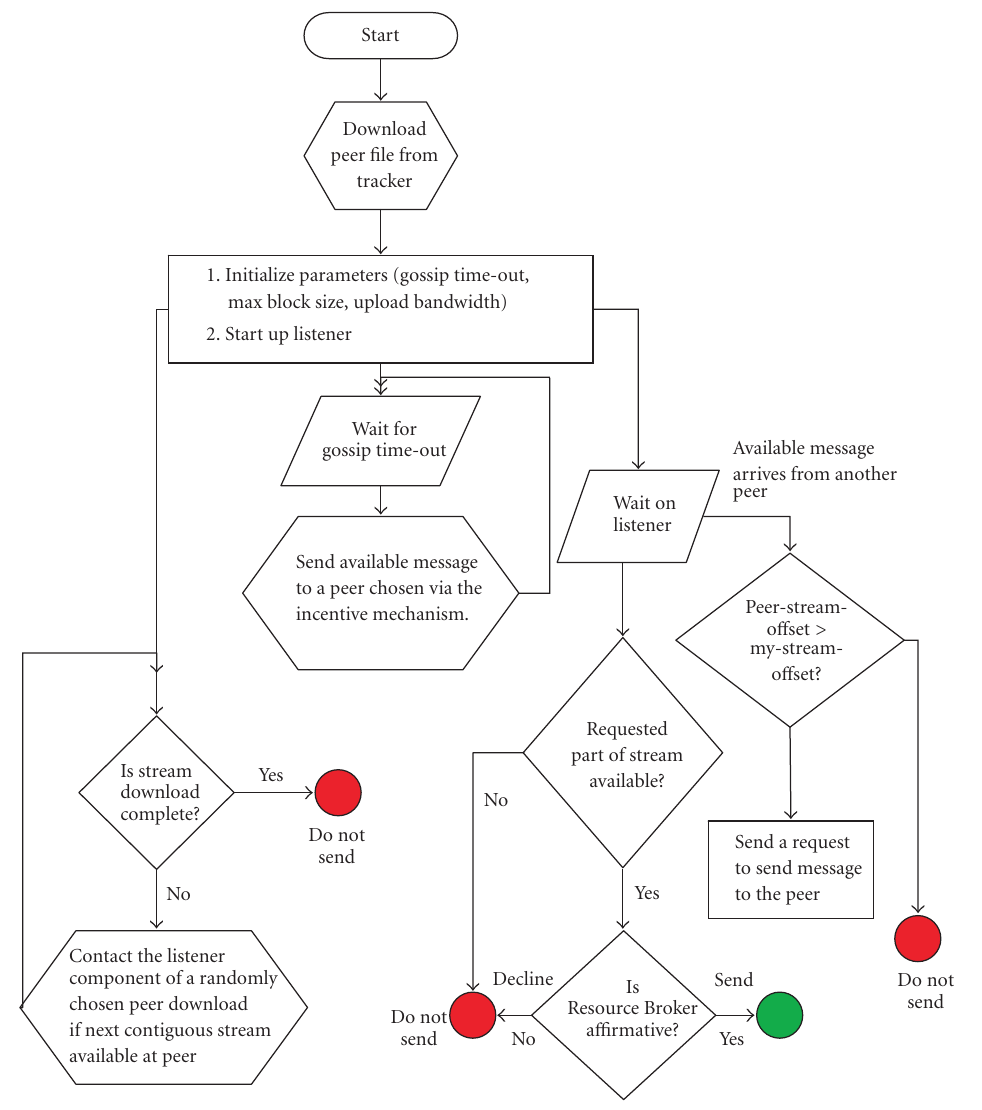
Figure 9: Streaming Operation of nonsource